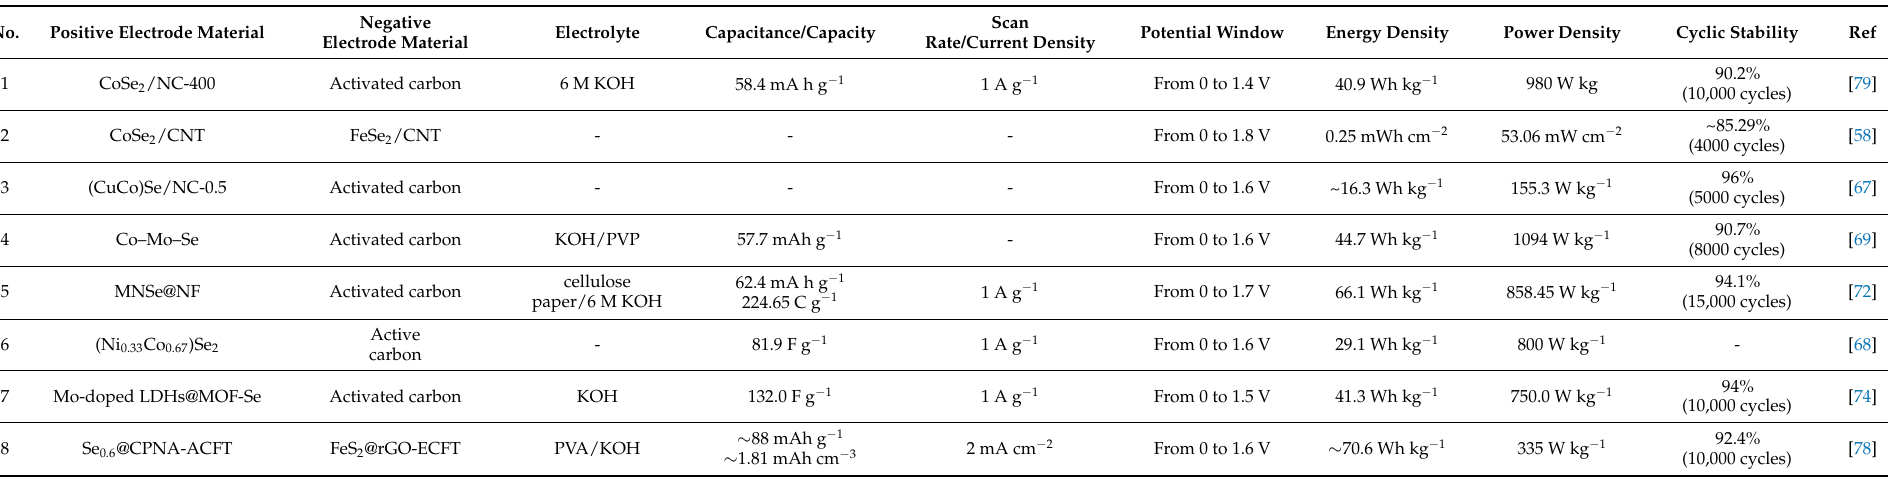
Table 4. Summary of the electrochemical parameters of the selenization-treated MOF-based electrodes in two-electrode measurements